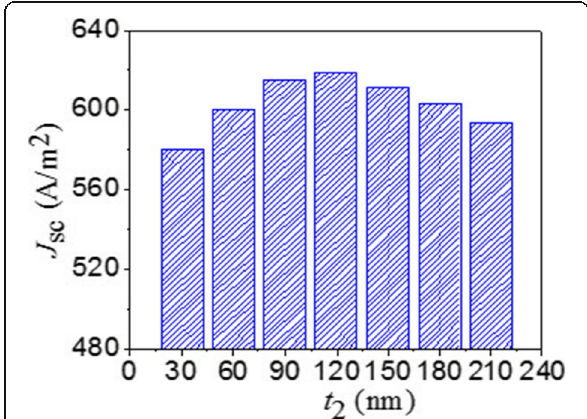
Fig. 5 Short-circuit current density with the GaAs nanoantenna ’ s thickness under the TM polarized